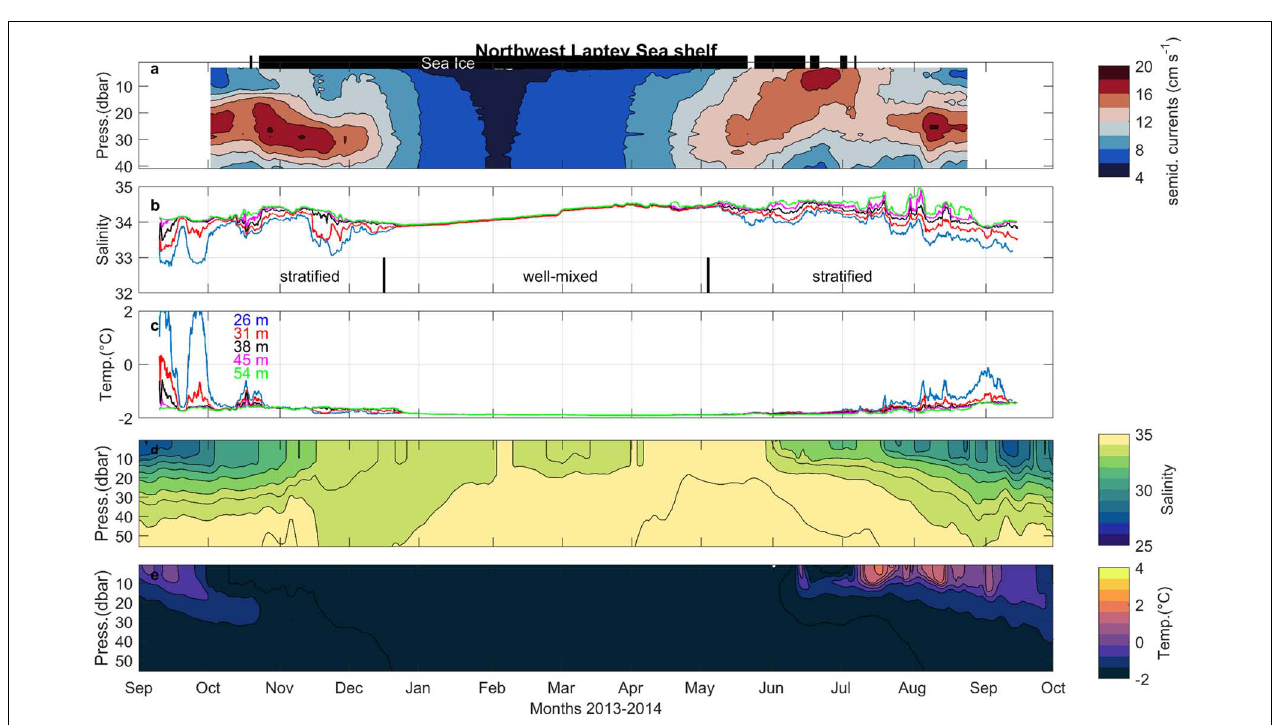
FIGURE 7 | Salinity (top) and potential temperature (bottom) profiles from deployment in 2013 (thick lines) and recovery in 2014 (thin lines) of the three moorings.